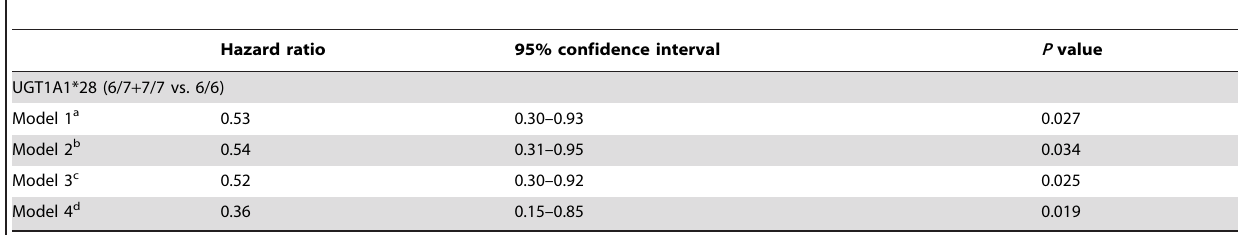
Table 3. Graft-loss risk in recipients with UGT1A1*28 polymorphism 6/7 + 7/7 versus 6/6 by Cox regression